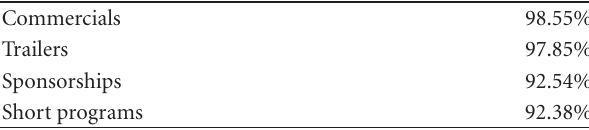
Table 3: Recall R seqret of repeated segments per category in TVTrain on a per shot basis.